Question: Produce a descriptive caption suitable for publication.
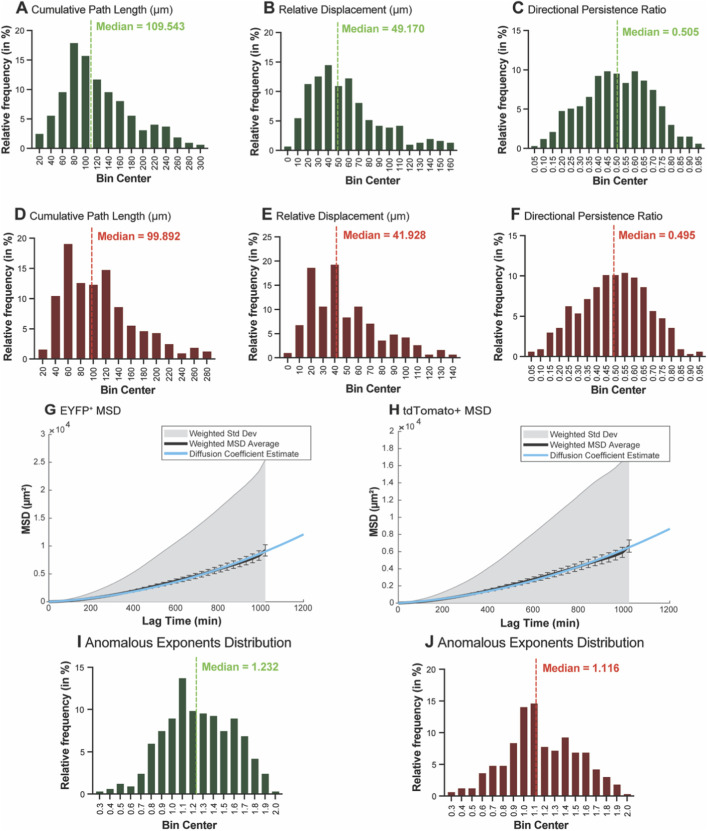
Answer: Migration metric distributions and MSD analysis across EYFP + and tdTomato + tracked cell populations. (A–C) : n = 336 EYFP + tracked cells. (D–F) : n = 337 tdTomato + tracked cells. All cells tracked across the same 12 assembloids from 4 independent imaging sessions. Distributions are shown as relative frequency histograms. Dashed lines indicate the median for each metric. Speed and speed variance distributions for both channels are shown in Supplementary Figure S4 . (A,D) Cumulative path length (in µm): total 3D Euclidean path traveled by each cell across all consecutive timeframes. Right-skewed distributions with medians of 109.5 µm (EYFP + ) and 99.9 µm (tdTomato + ). (B,E) Net displacement (in µm): straight-line Euclidean distance between each cell’s initial and final 3D position. Right-skewed distributions with medians of 49.2 µm (EYFP + ) and 41.9 µm (tdTomato + ). (C,F) Directional persistence ratio (dimensionless, 0–1): ratio of net displacement to cumulative path length. Broad distributions across the full range with medians of 0.50 for both EYFP + and tdTomato + . Values near 0 indicate circuitous, non-directional paths; values near 1 indicate straight, persistent trajectories. (G) MSD as a function of lag time (minutes) for 336 EYFP + tracked cells. (H) MSD as a function of lag time for 336 tdTomato + tracked cells. For both panels: gray shaded region: weighted standard deviation across all cell tracks; black line with error bars: weighted MSD mean; blue line: parabolic fit to the mean MSD curve. The upward-curving parabolic shape of the mean MSD curve is consistent with directed diffusion ( R 2 = 0.998 for both channels). EYFP + fit: D = 0.317 μm 2 /min; tdTomato + fit: D = 0.276 μm 2 /min. (I,J) Distribution of anomalous diffusion exponents (α) from per-cell log-log MSD fitting for (I) 336 EF1α-EYFP + tracked cells (median = 1.232) and (J) 336 SOX10-tdTomato + tracked cells (median = 1.116). Dashed lines indicate the median for each distribution.